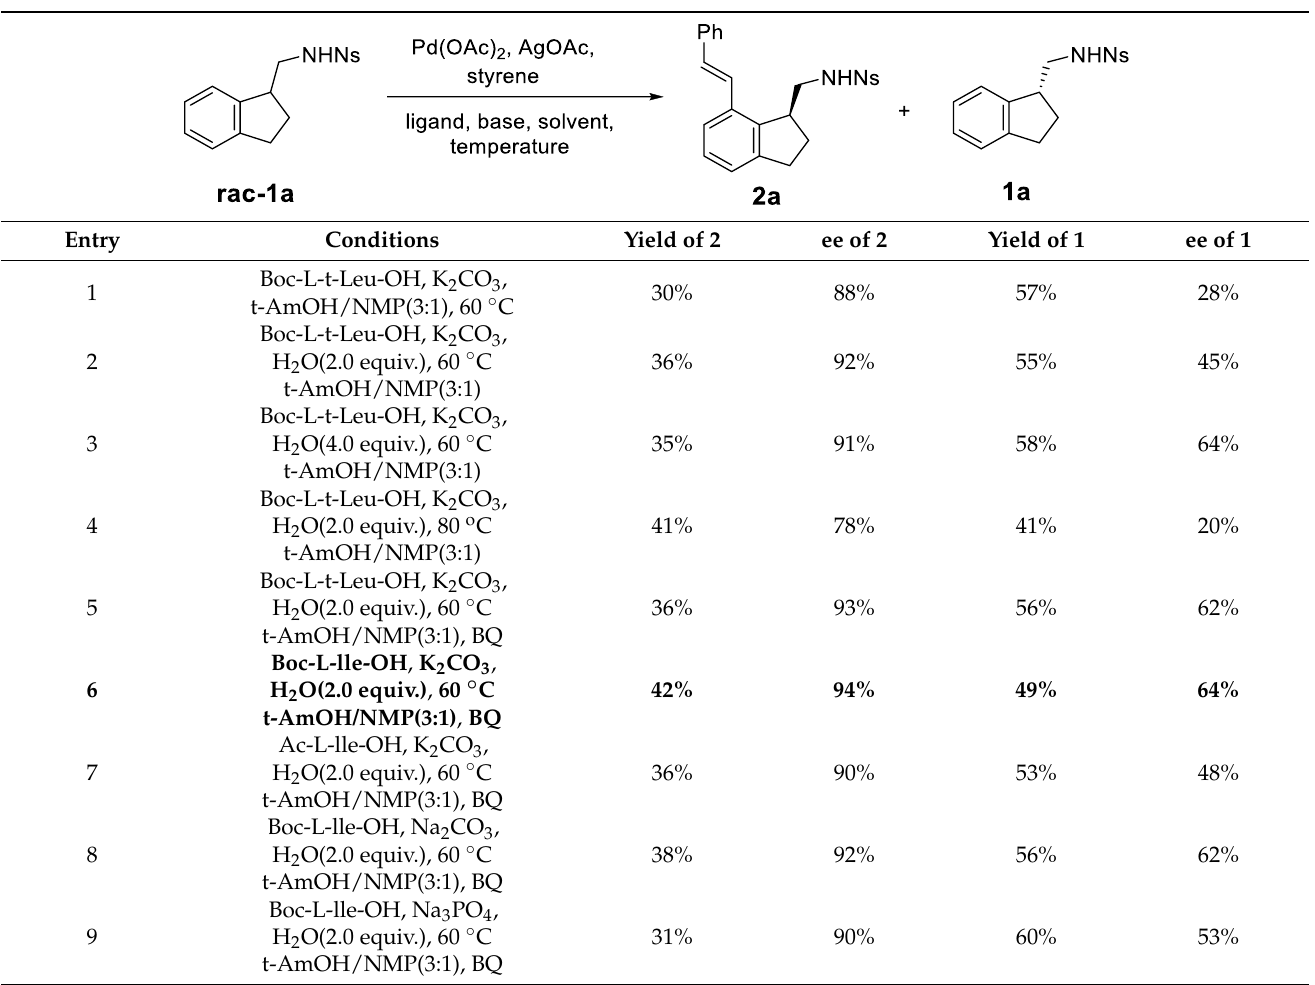
Table 1. Optimization of conditions for the kinetic resolution of β -alkylphenyl ethylamine.